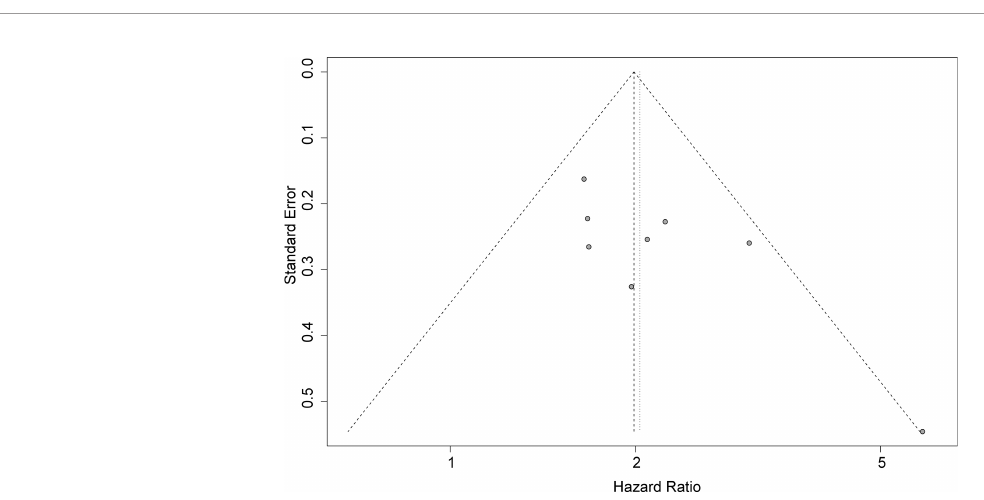
FIGURE 4 | Funnel plot for detecting publication bias.